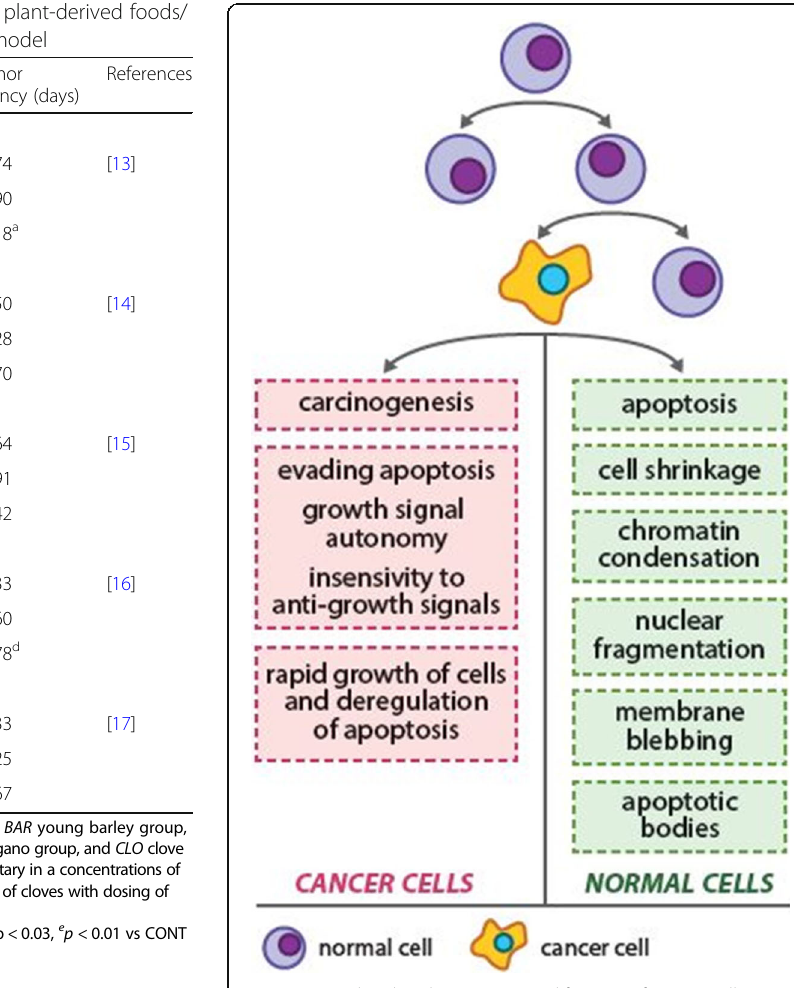
Fig. 4 Deregulated and aggressive proliferation of cancer cells is one of the major features of carcinogenesis. For more details, see the text –– the section “ Inhibition of proliferation